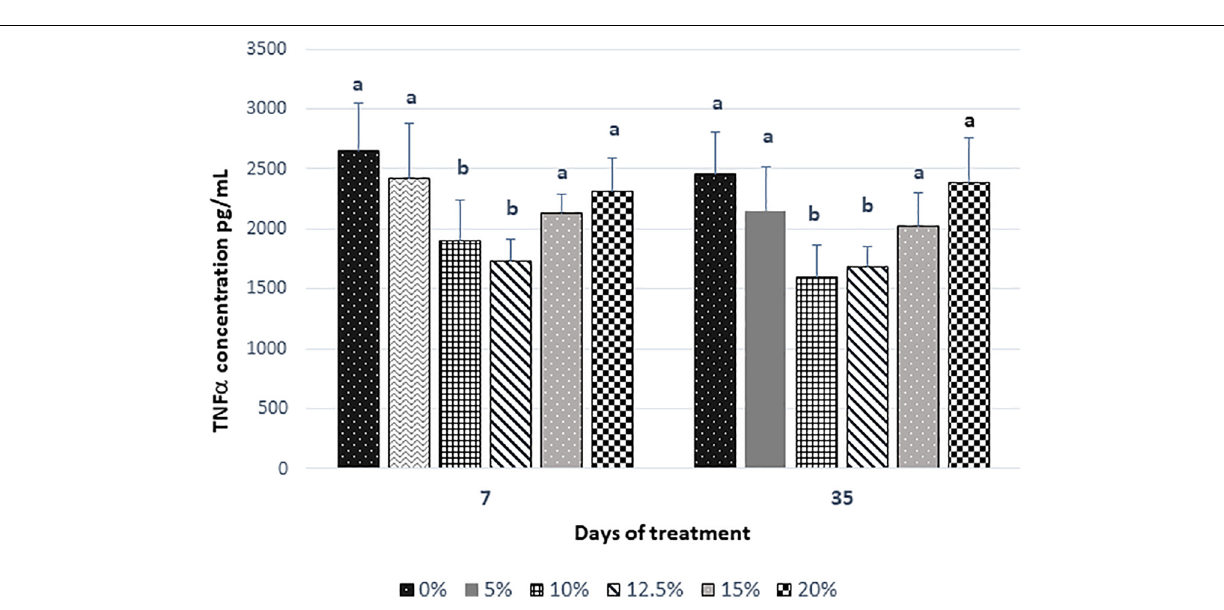
Frontiers in Plant Science |